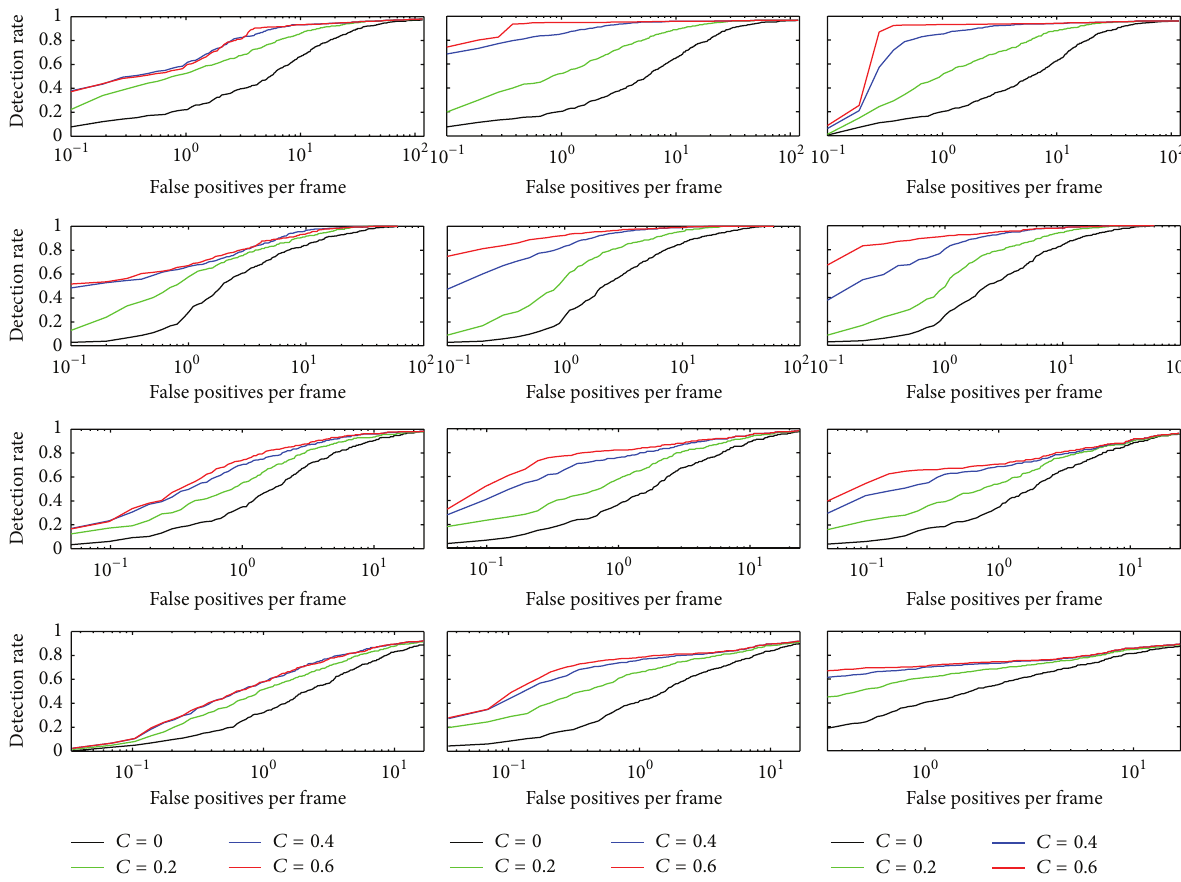
Figure 4: Comparison of parameter pair (𝜆,𝑛) . Each row of these subimages represents (detection rate/false positives per frame) curve for each dataset, which are “Multiple Flow,” “City Center,” USC(A), and INRIA dataset in order from top to bottom. The stage numbers 𝑛 of these three columns are 8, 12, and 16 in order from left to right. Each subimage represents the performance of added confidence 𝜆 for given dataset with stage number 𝑛